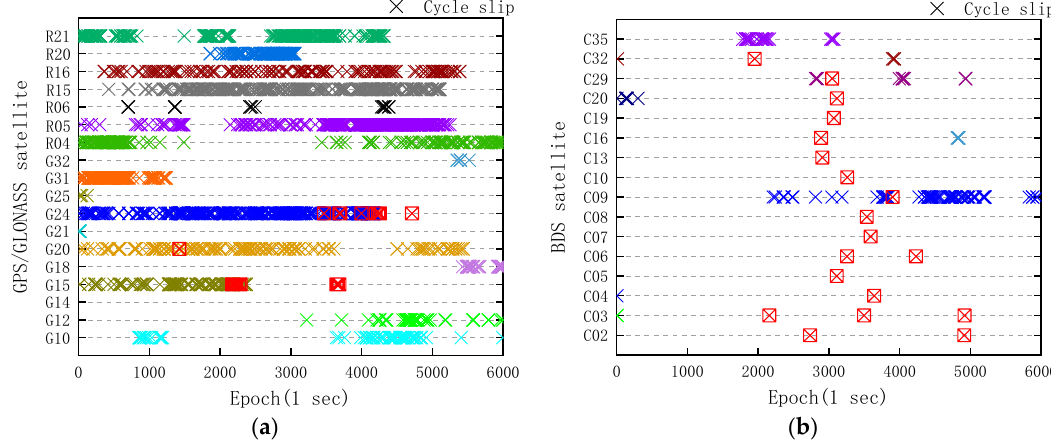
Figure 3. Huawei Mate30 carrier phase cycle slip detection of GNSS L1 band observations. ( a ) GPS and GLONASS; ( b ) BDS. The extra cycle slips of GPS and BDS satellites detected by measurement-based polynomial fitting (MPF) were marked with red boxes.